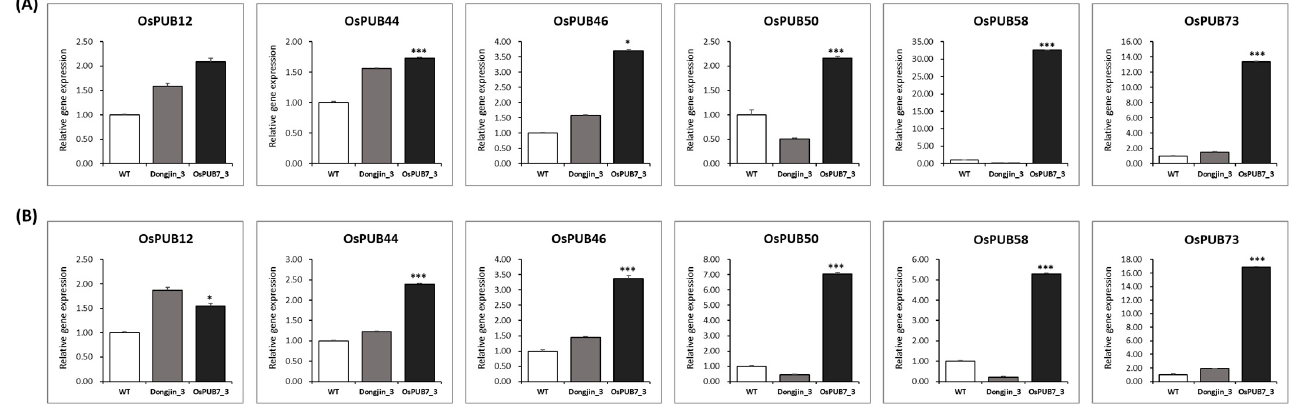
Figure 15. Relative gene expression determined using qRT-PCR. ( A ) Gene expression of six candidate differentially expressed genes (DEGs) in WT and PUB7-GE (K343-8-1) after drought stress treatment. ( B ) Expression of six candidate DEGs in WT and PUB7-GE (K343-8-1) after salinity stress treatment. Error bars indicate SEs ( n = 3, three biological replicates). Values for WT and PUB7-GE differed significantly. *, p < 0.05; ***, p < 0.001.